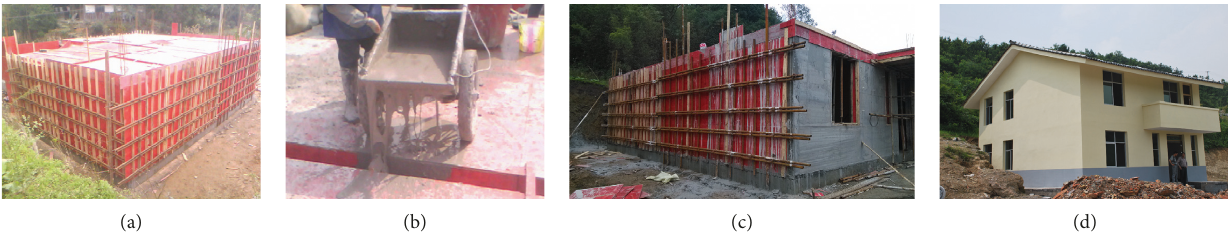
Figure 5: Cast-in-situ phosphogypsum residential project example. (a) Formwork. (b) Pouring. (c) Form stripping. (d) Building.